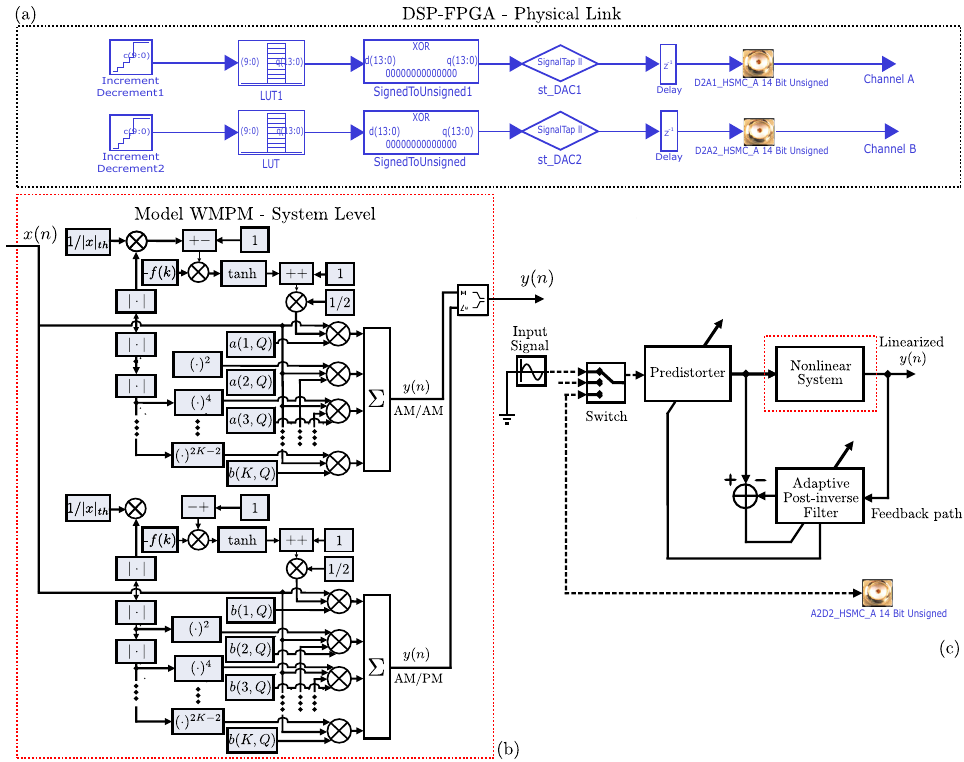
Figure 2. Indirect learning approach (ILA) algorithm block diagram: ( a ) DSP-FPGA physical link for data conditioning, ( b ) adaptive weighted memory polynomial model (W-MPM) modeling stage, and ( c ) proposed ILA system control-based